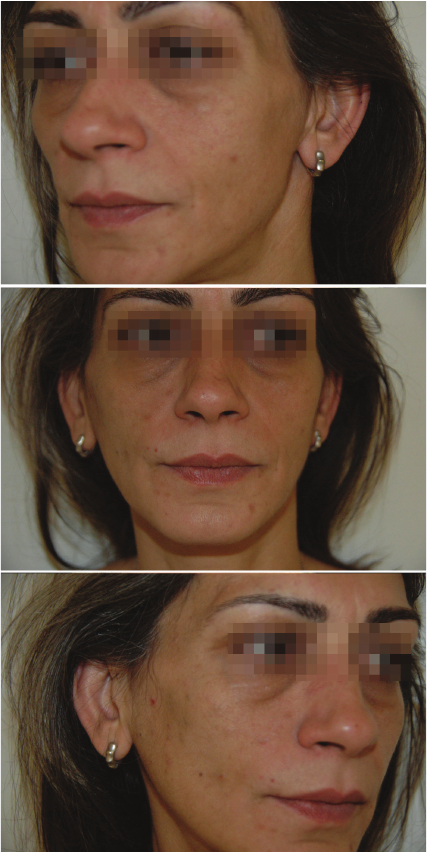
Figure 5: 42 year-old woman 3 years after a superficial parotidec- tomy for a benign tumor of the parotid gland with immediate recon- struction by an autologous fat graft (13mL). After that procedure, the result remained very good on the aesthetic point of view until a weight loss of 17kg leading to a partial atrophy of the fat graft and to a clinical preauricular defect. There is no Frey’s syndrome as objectivated by a Minor’s starch-iodine